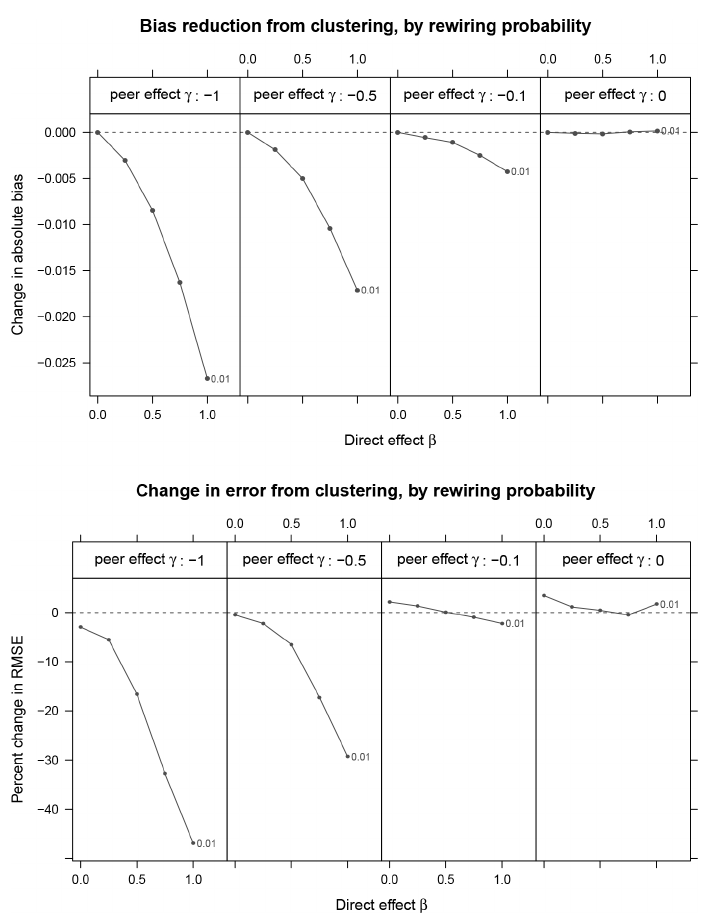
Figure 9 Changes in bias and root-mean-squared-error (RMSE) due from clustered random assignment for small world networks with non-monotonic responses and p